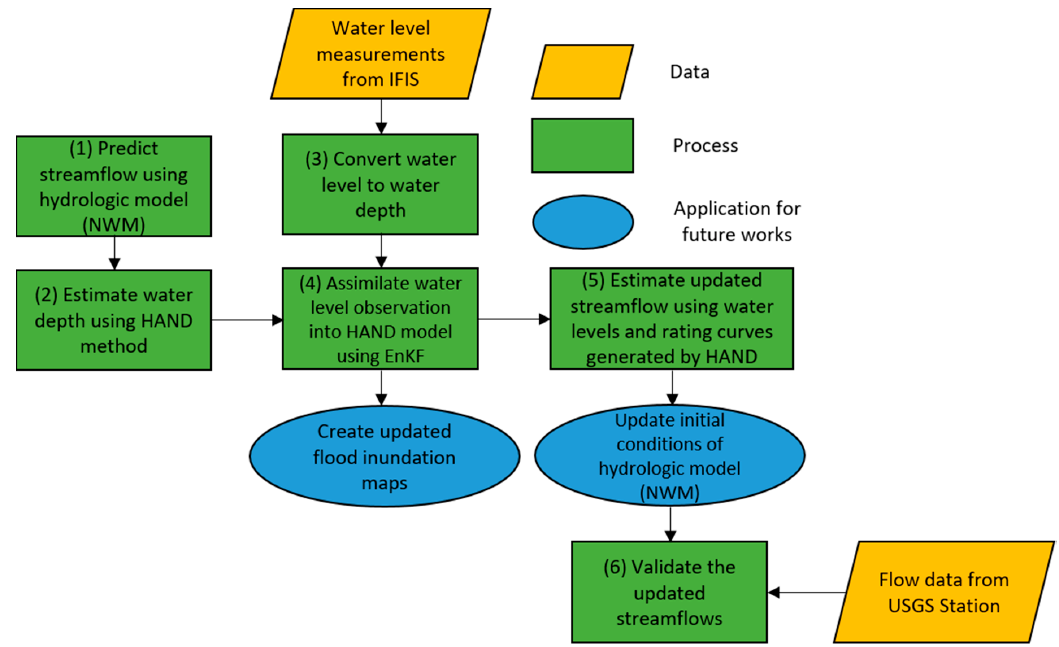
Figure 2. Schematic methodology.